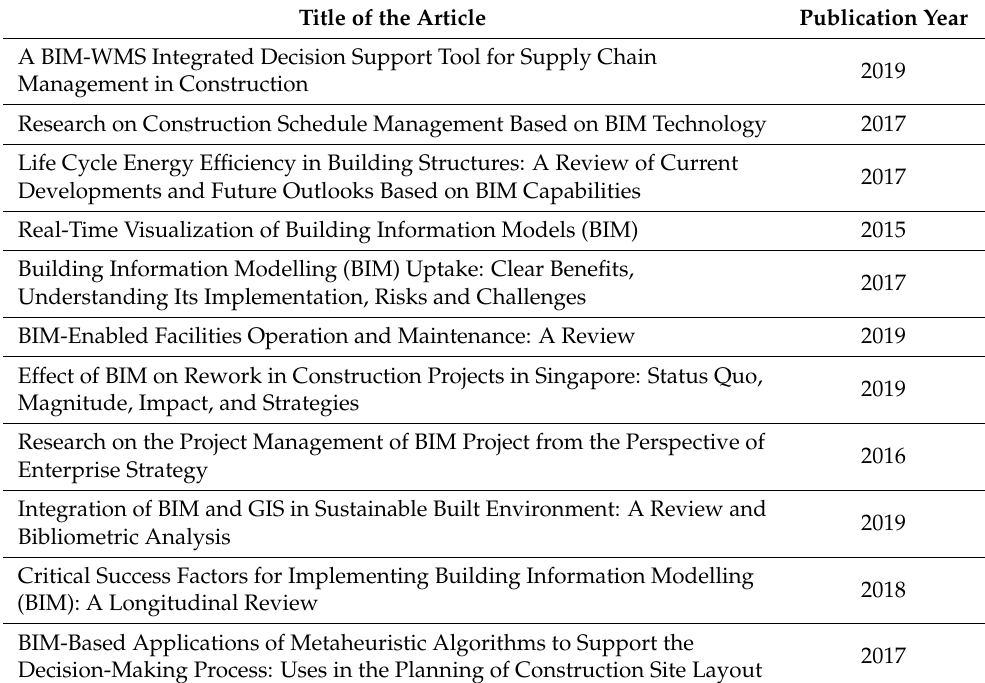
Table A4. Reviewed studies in Section 3.2.4 (sorted by order of